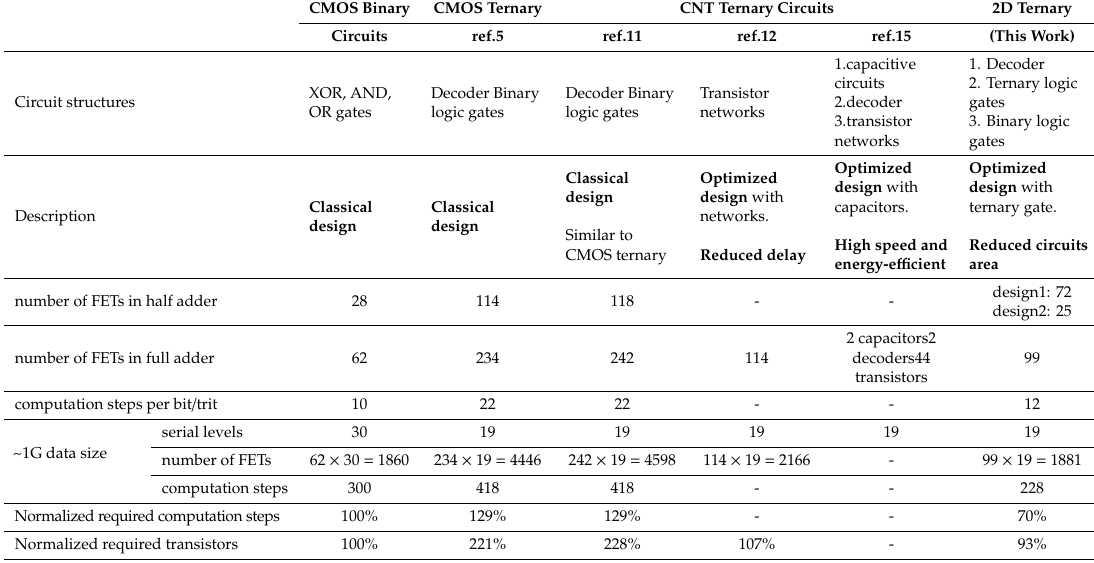
Table 1. Comparison table of di ff erent ternary circuit designs. (Note: The number in the table should be the less, the